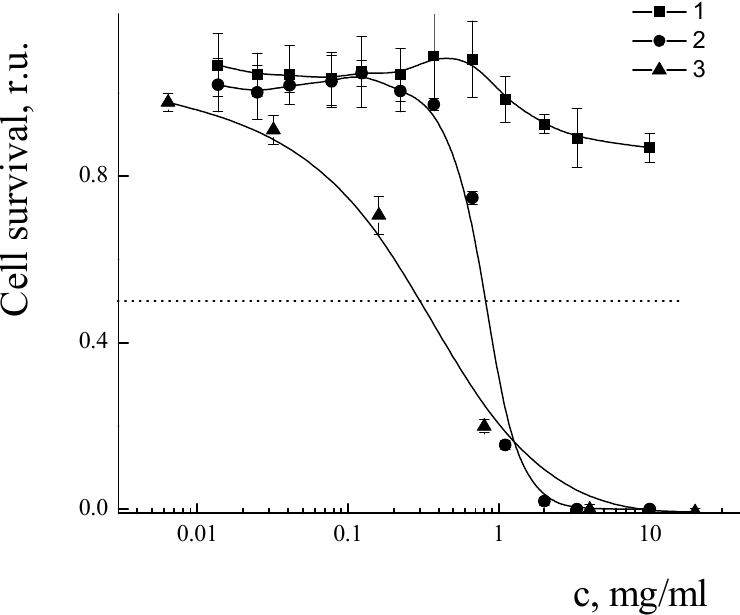
Figure 16. Cell survival after treatment with PLAMs–us (1); PLAMs–PTX (2); and Paclitaxel-Teva (3).